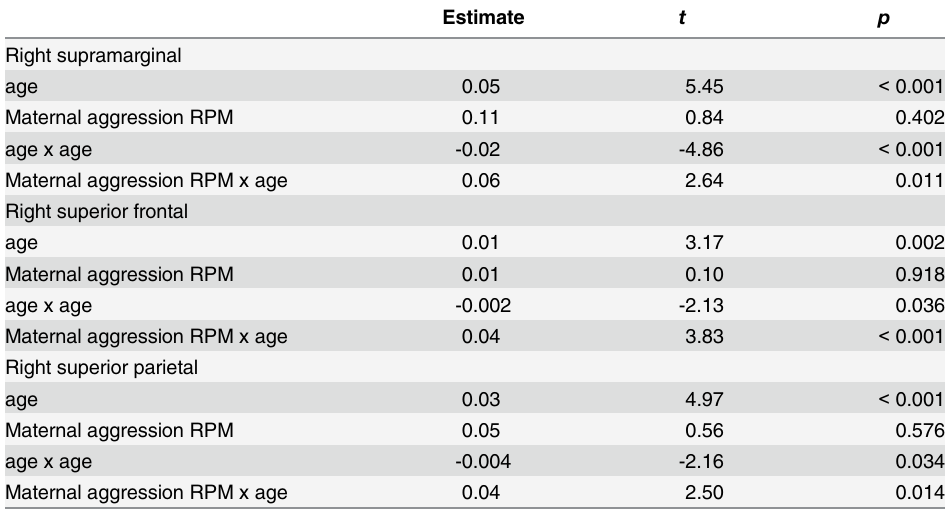
NB: Models without covariates are not presented for simplicity. RPM = rate per